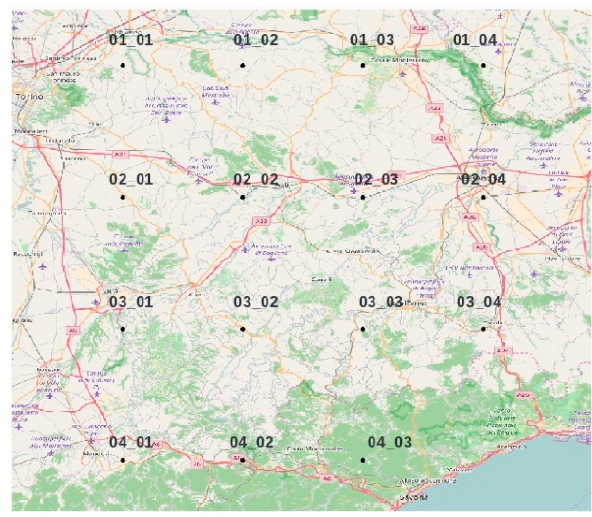
Figure 1. Location of the 15 grid points over the Piedmontese territory. Table 1. Coordinates of grid points (longitude and latitude, in degrees and decimals, ◦ E and ◦ N, respectively, elevation in m a.s.l.) and soil texture of grid points considered in the study (the code refers to the [36] classification, also used by the US Department of Agriculture). Grid Points Coordinates Elevation (m